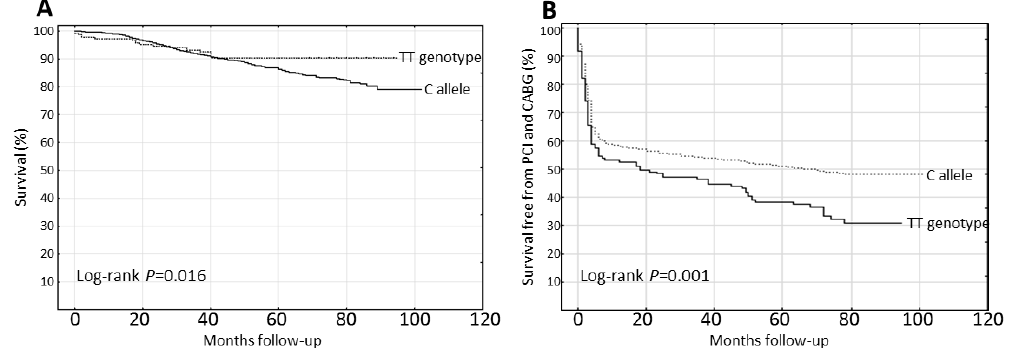
Figure 1. 7-year Kaplan–Meier curves for crude survival within the recessive model of the CYBA c.214C > T polymorphism: ( A ) Significantly lower risk of death (higher probability of overall survival) among the subjects with the TT genotype in comparison to C allele carriers. ( B ) Significantly higher risk of undergoing PCI and / or CABG among the subjects with the TT genotype in comparison to C allele carriers. PCI: percutaneous coronary intervention; CABG: coronary artery bypass grafting.